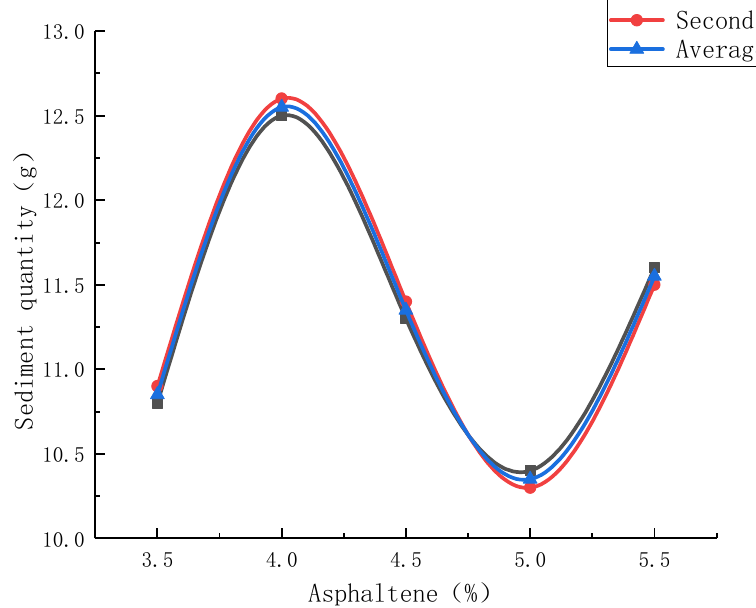
Figure 7. Sediment quality curves at different asphaltene content.